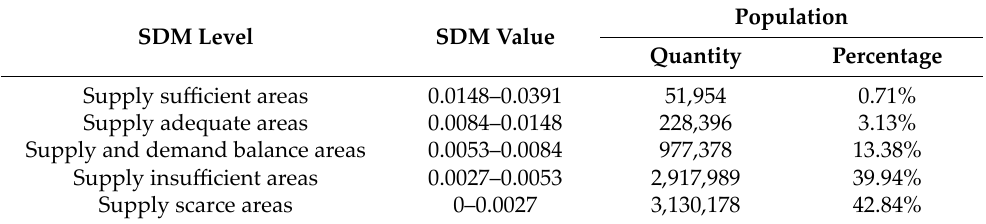
Table 6. Hierarchical statistics of SDM of public physical health resources in central Tianjin.